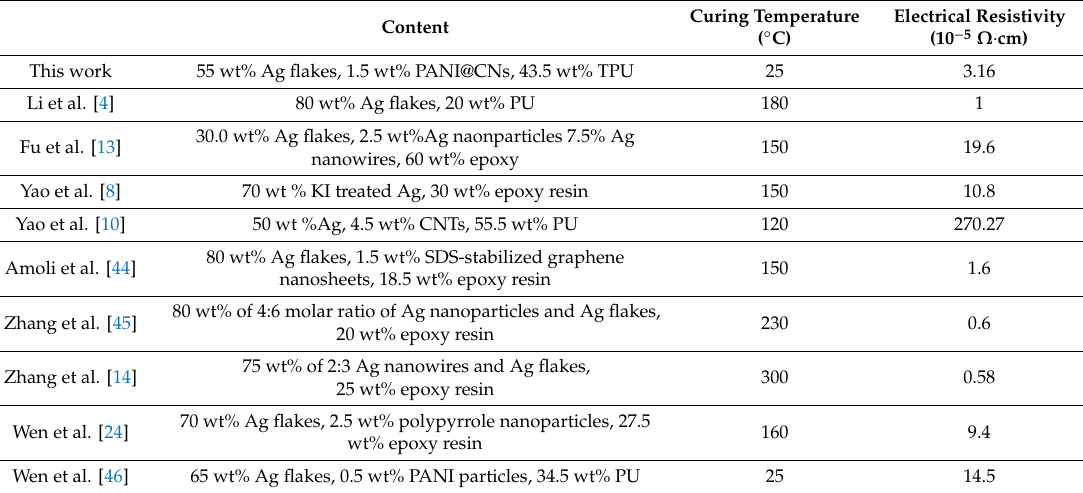
Table 2. The comparison of conductivities of literature ECAs.